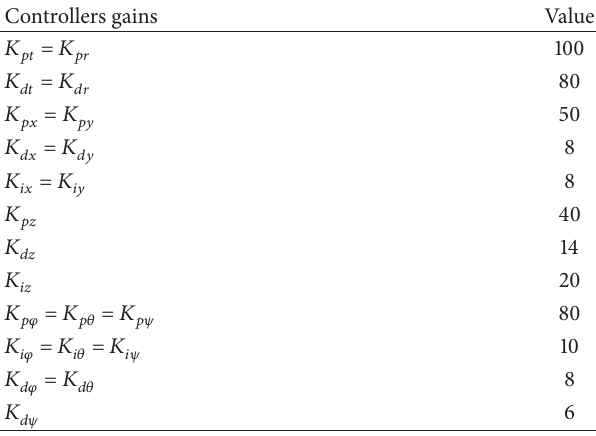
Table 1: MBA and PID controller gains values.